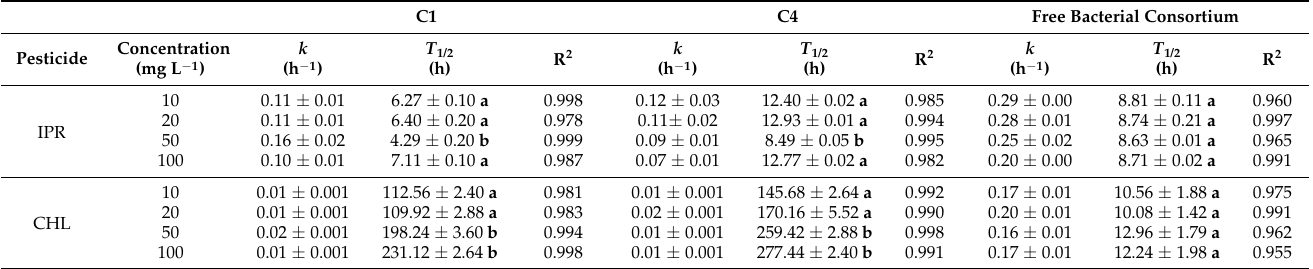
Table 2. First-order kinetics parameters for iprodione (IPR) and chlorpyrifos (CHL) removal at different concentrations of 10, 20, 50, and 100 mg L − 1 with the individual bacterial strains (C1 and C4) and free bacterial